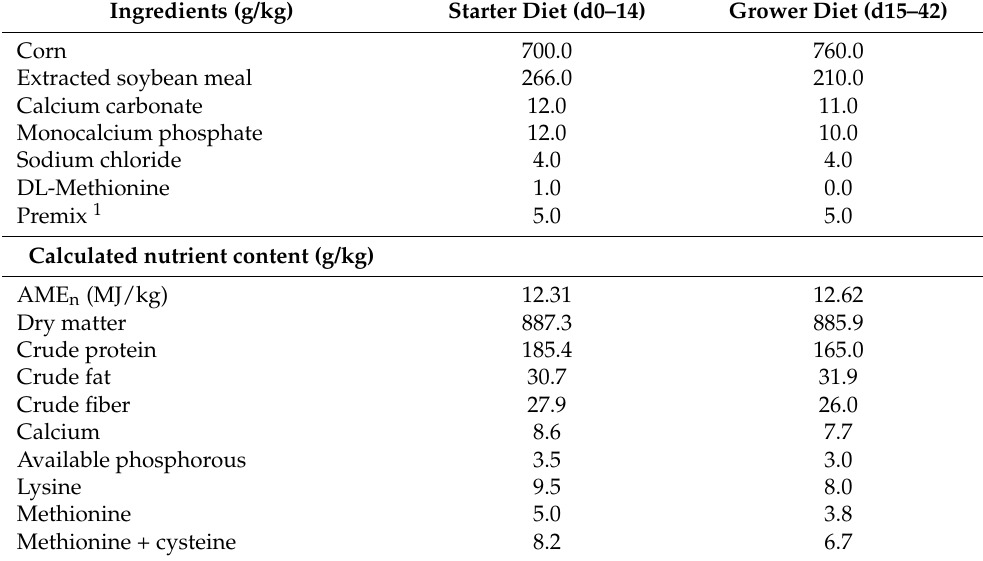
Table 1. Dietary composition and calculated nutrient content of control